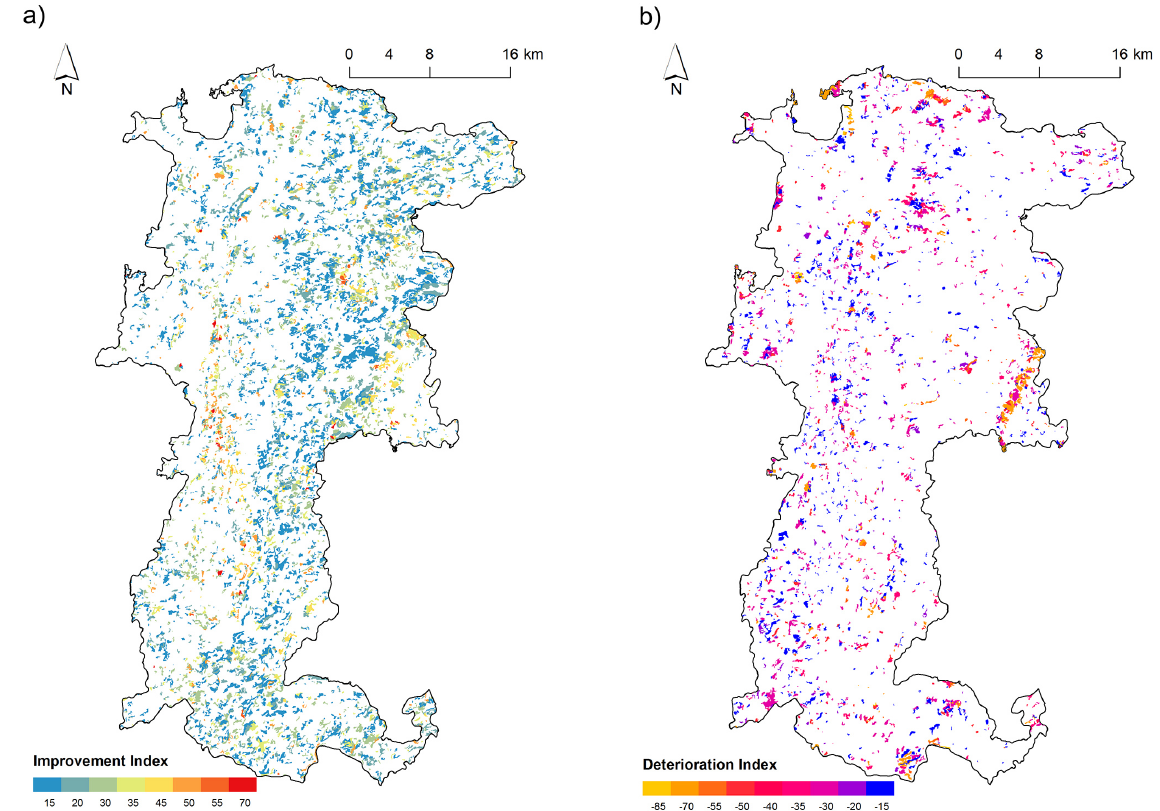
Figure 3. The spatial evolution index of karst rocky desertification from 2000 to 2010 (a) improvement index; (b) deterioration index.